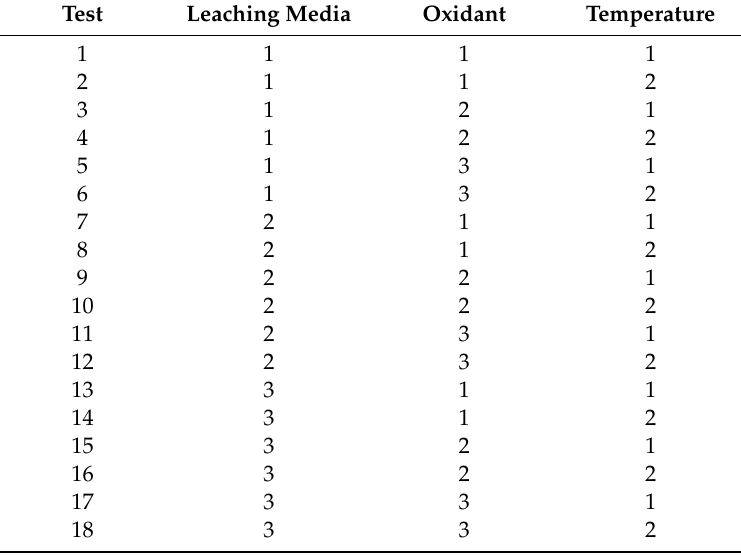
Table 3. Experimental design implemented to study the di ff erent aqueous media, oxidant agents and temperature. Test Leaching Media Oxidant Temperature